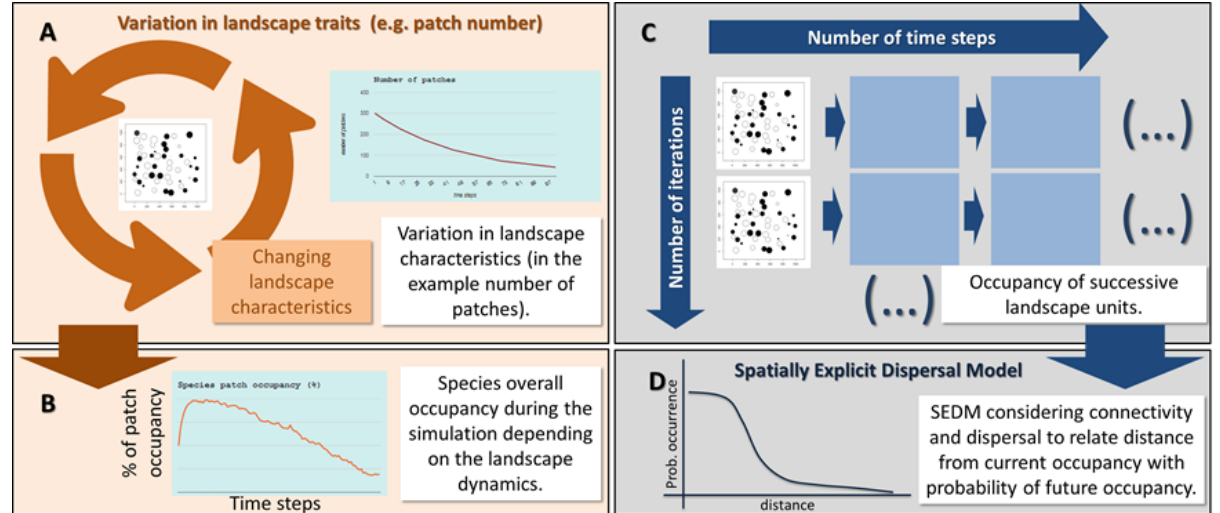
Figure 1. MetaLandSim simulations: At the landscape scale (panels A and B ) the software resorts to the IFM to simu- late metapopulational dynamics in a landscape unit ( A ) with changing characteristics (in this case a decreasing num- ber of habitat patches at each time step as shown in the graph). As output MetaLandSim provides the species occu- pancy throughout the simulation. In this case, the occupancy as the landscape loses a given percentage of its habitat patches at each time step ( B ). At the biogeographical scale (panels C and D ), MetaLandSim simulates the dynamics of the metapopulation inside each landscape unit and allows the colonization of the next landscape unit until all the time steps are spent. This process that should be repeated ( C ) producing an output, the Spatially Explicit Dispersal Model (SEDM), that relates species probability of occurrence with distance from nearest current presence ( D